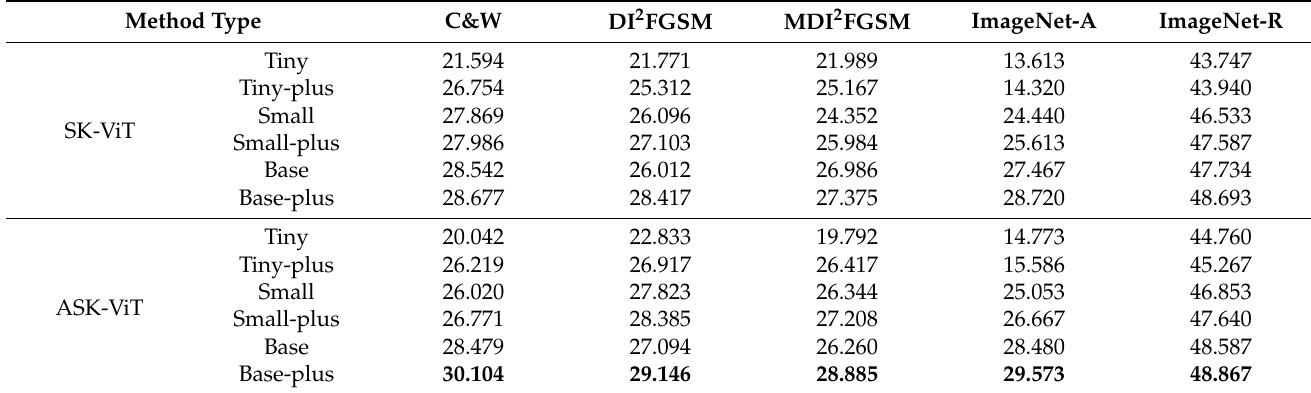
Table 5. Comparison of the robustness of SK-RVT and ASK-ViT